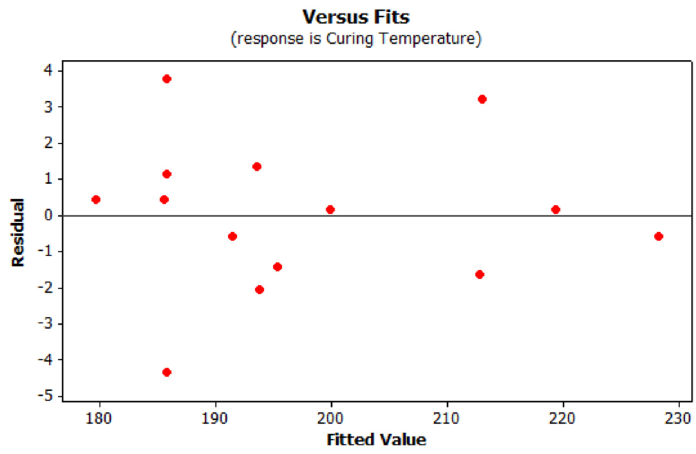
Molecules 2017 , 22 , 1850 10 of 19